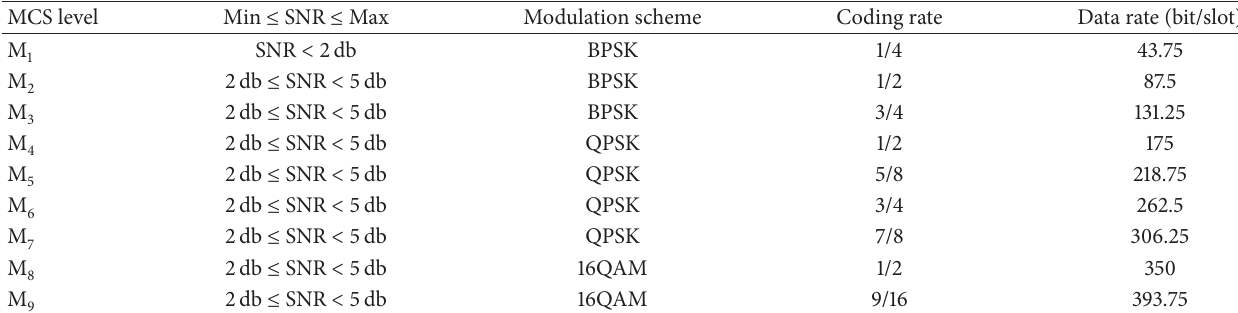
Table 1: MCS level and data